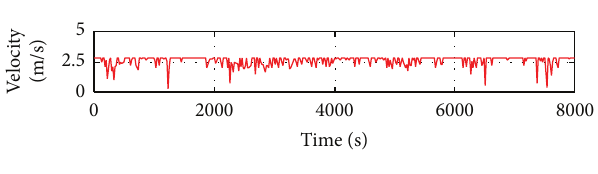
Figure 6: Otter board trajectories.